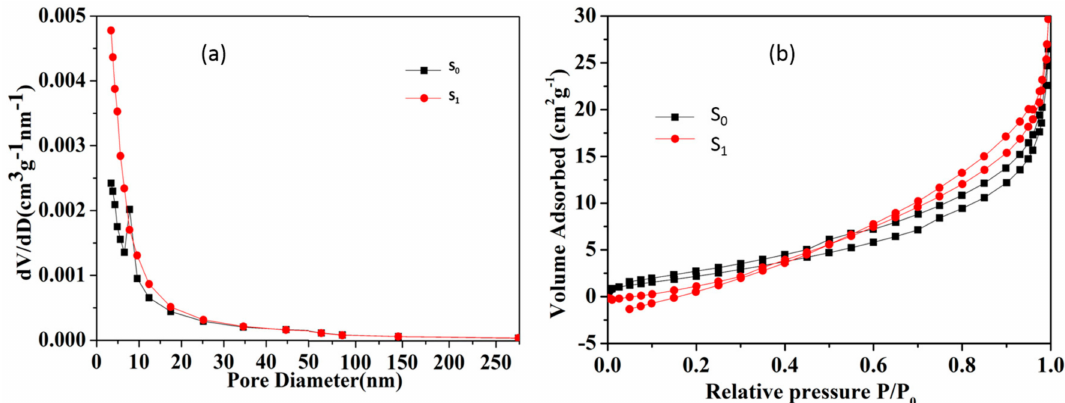
Figure 4. ( a ) Pore diameter distribution of raw sericite (S 0 ) and thermal-activated sericite (S 1 ); ( b ) the isotherm of N 2 adsorption-desorption on sericite before and after thermal modification.